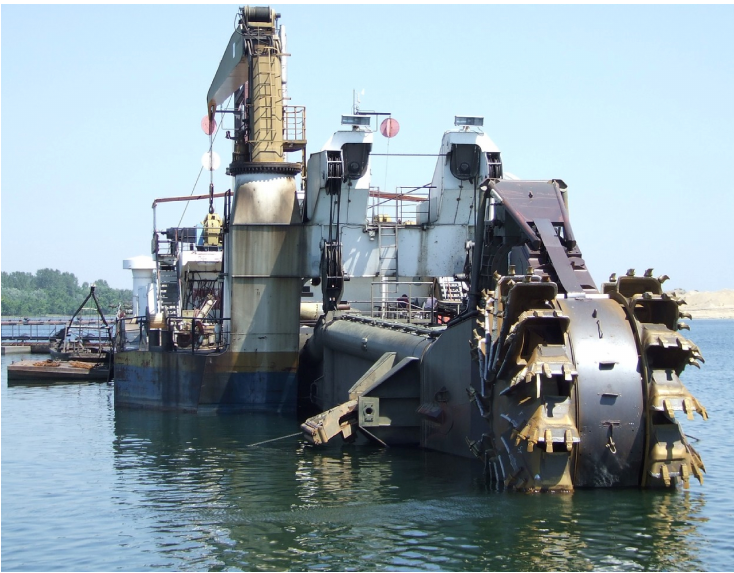
Figure 3. Bucket-wheel dredger “Kovin I” with bucket wheel type UCW-450 [19].